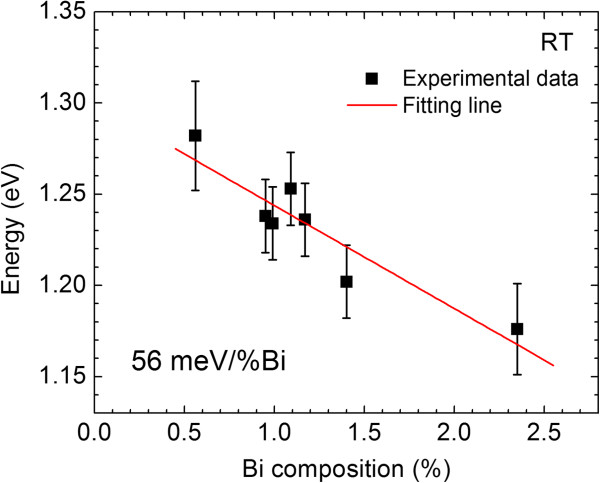
Bandgap energy of InPBi measured from absorption spectra as a function of Bi composition. The error bars of the experimental data are labeled. The solid line is the fitting line of the experimental data.